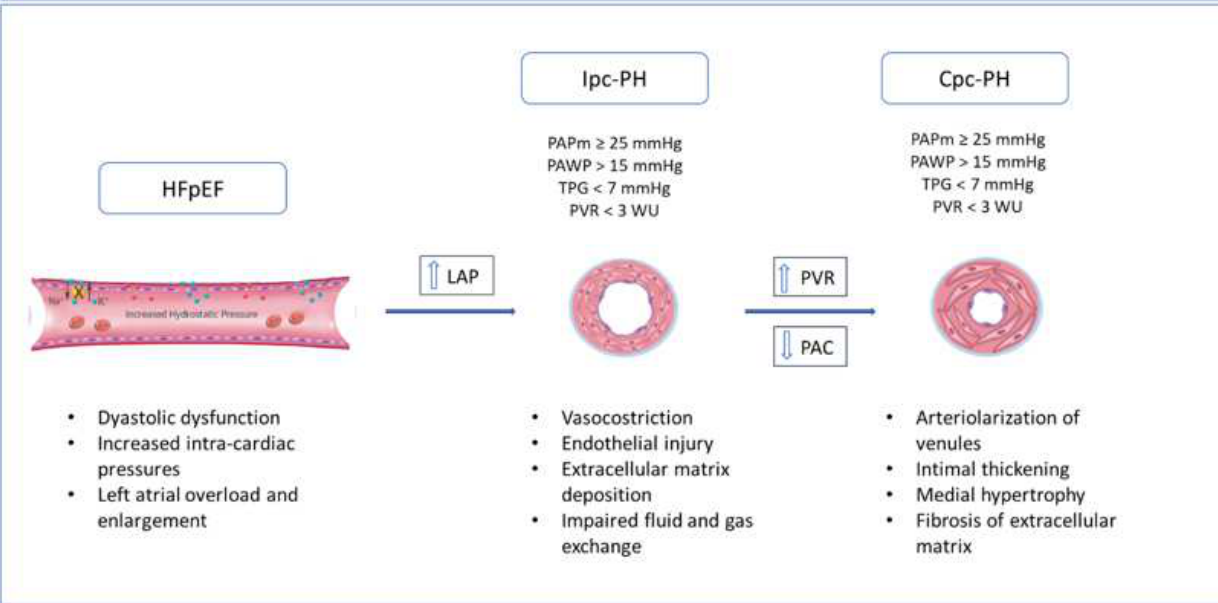
Figure 1. Development of pulmonary hypertension in HFpEF: pathobiological vessels’ alterations and hemodynamic changes from isolated pre-capillary (Ipc) to combined pre- and post-capillary hypertension (Cpc-PH).